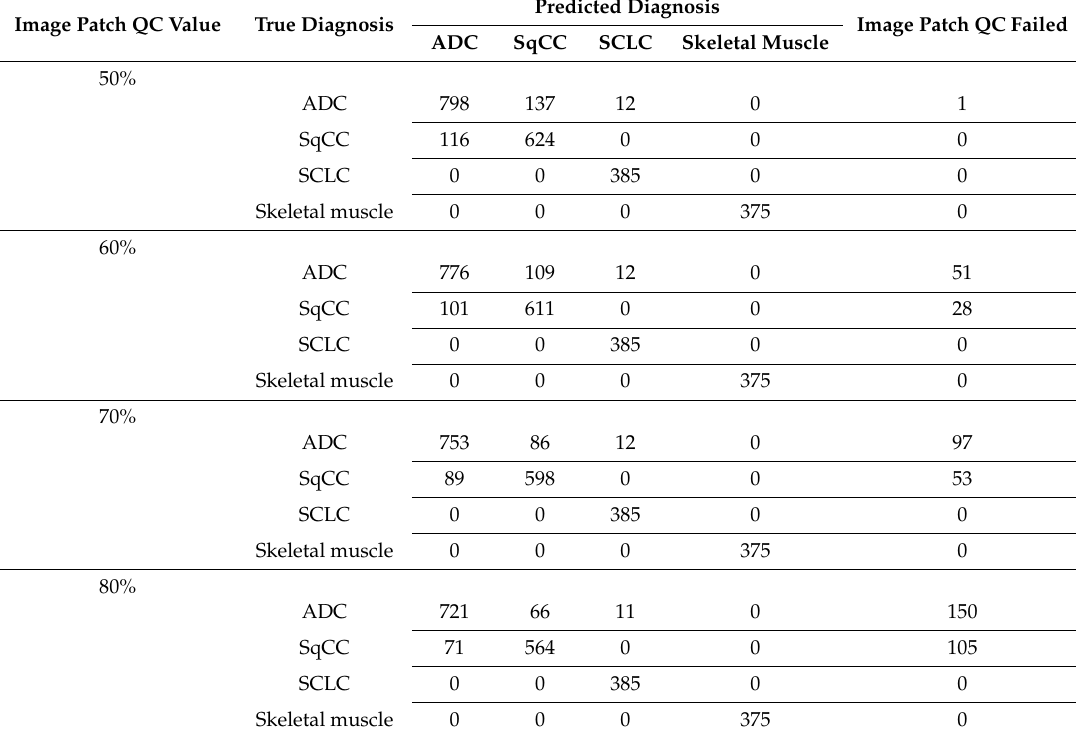
Figure A1. Loss and classification accuracy of the final CNN model. Table A1. True and predicted diagnoses of test set image patches according to different image patch QC values.